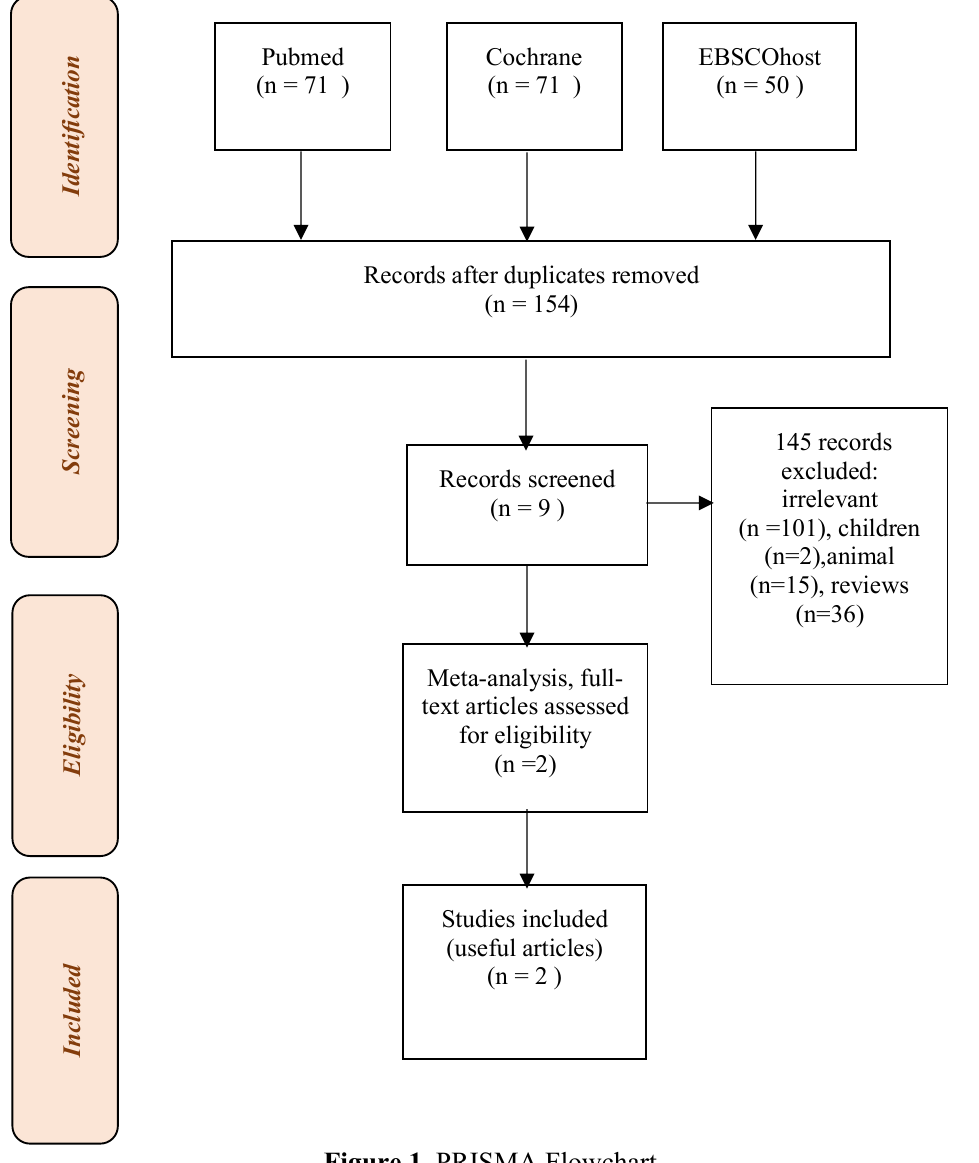
Figure 1. PRISMA